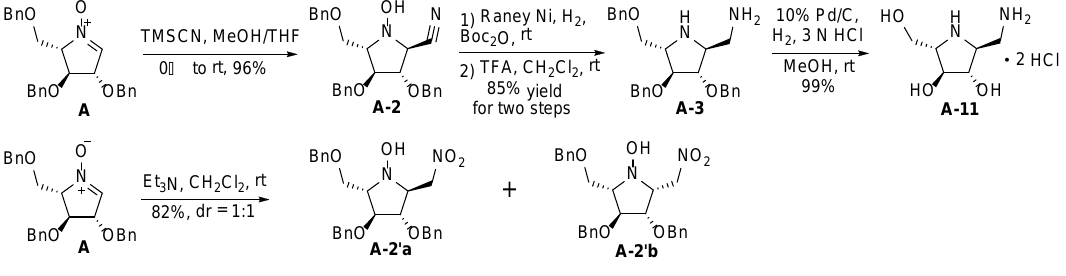
Scheme 1. Synthesis of compound A-11 from L - arabino -nitrone ( A ).